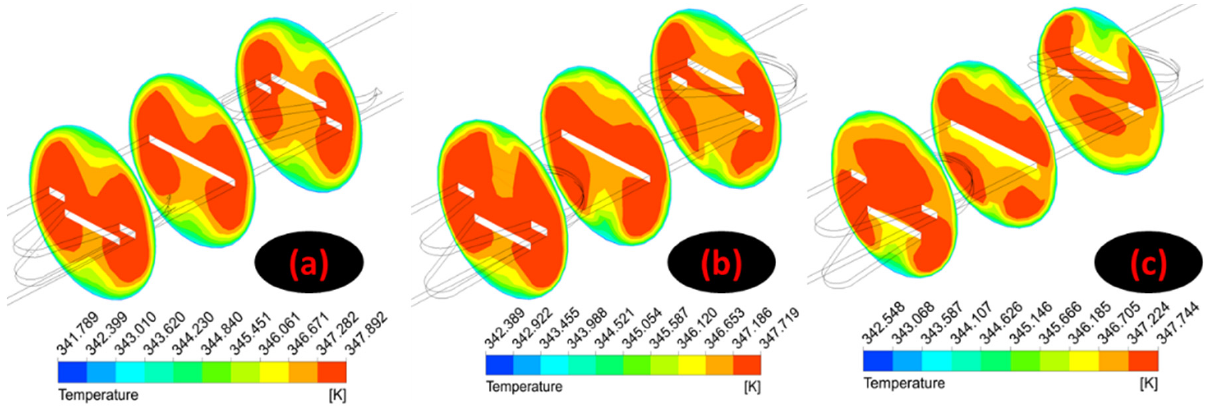
Figure 15. Temperature distribution along ( a ) 10°, ( b ) 15° and ( c ) 20° PWT inserts at section x 1 , x 2 and x 3 .